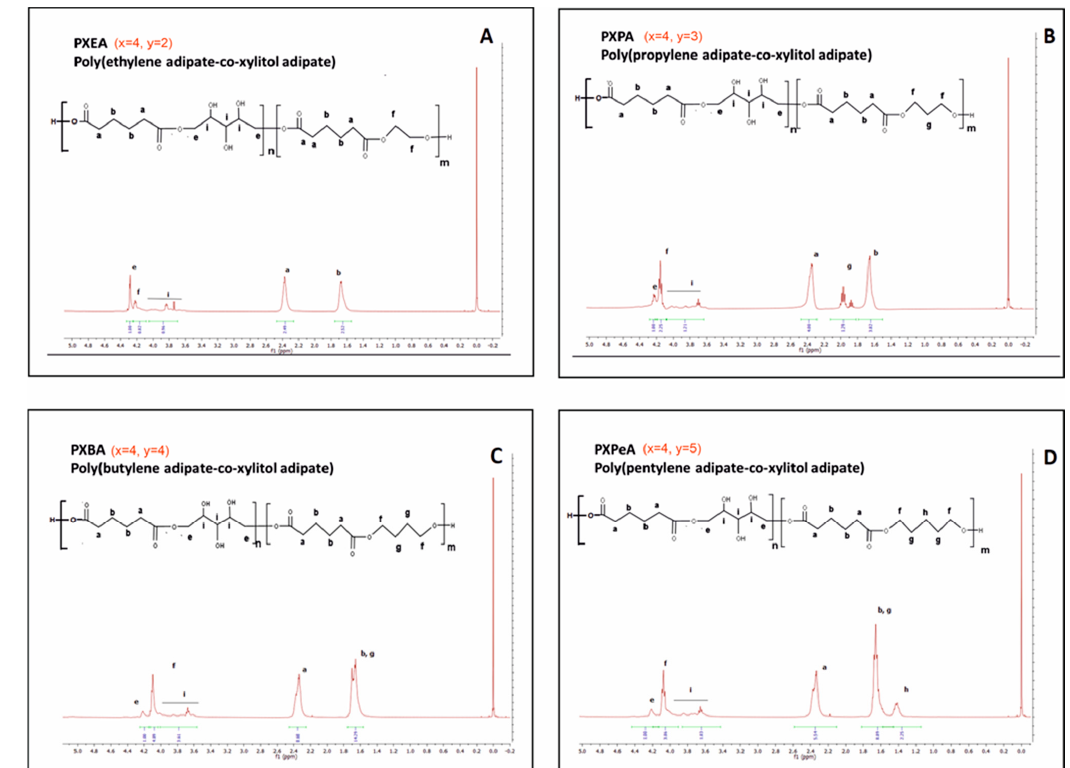
Figure 3. 1H NMR of PXEA ( A ), PXPA ( B ), PXBA ( C ), and PXPeA ( D ) prepolymers.